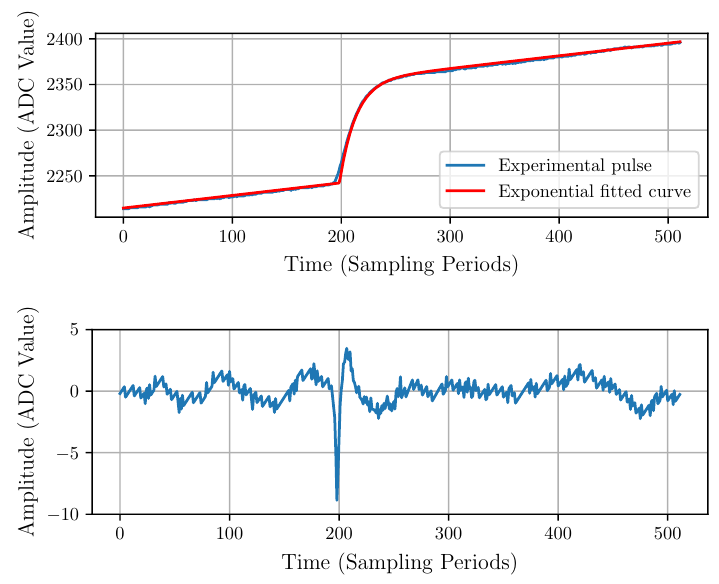
Figure 7. Exponential model fitting ( top ) with its corresponding residuals ( bottom